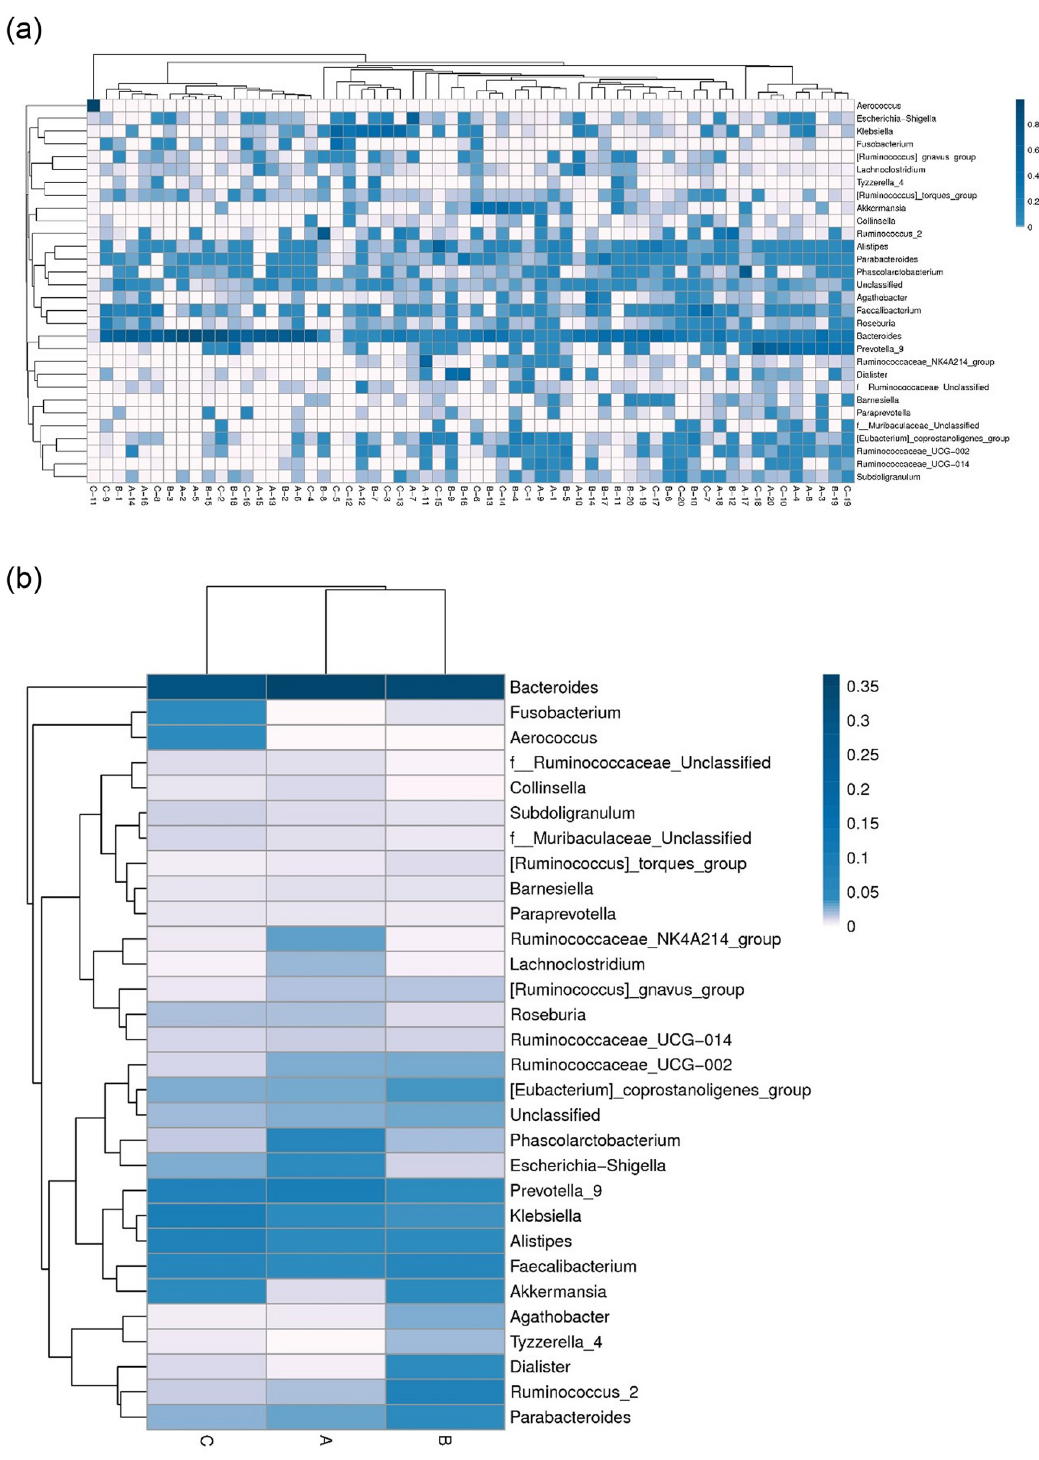
Fig 4. The heatmap analysis of the top 30 genus. a: Cluster of samples. b: Cluster of groups. The columns represent samples and/ or groups and the rows represent genus. The dendrogram above the heatmap is the cluster result of the samples and/or groups and the dendrogram to the left is the genus cluster. The colours in the heat map represent the relative abundance of the corresponding genus in the corresponding sample or group.